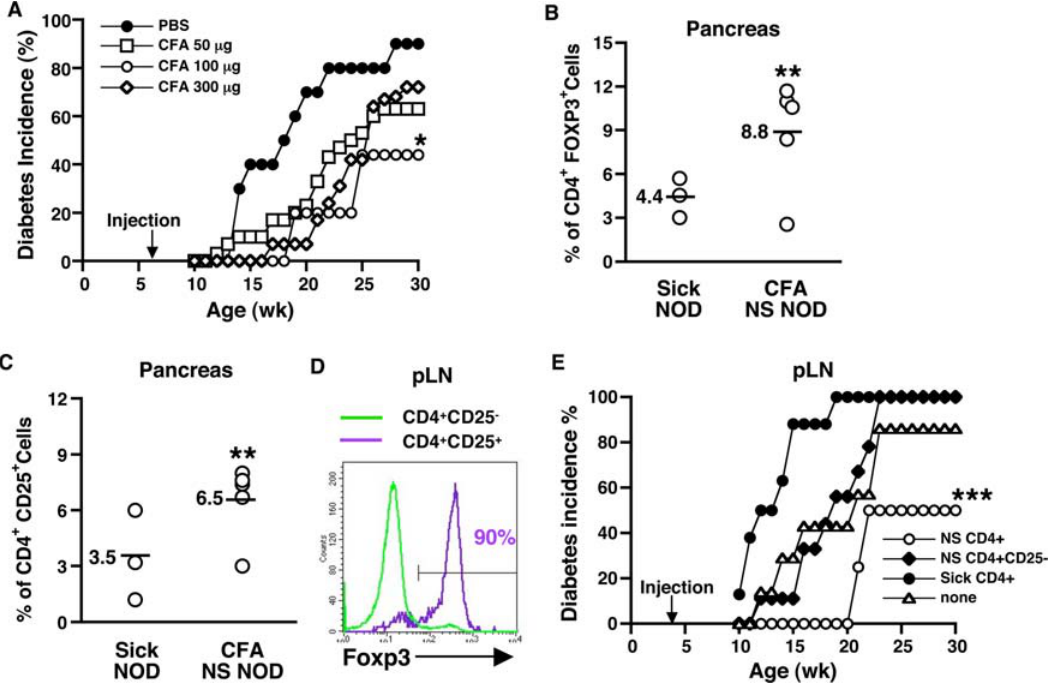
Figure 2. Disease-free CFA-treated NOD mice possess potent regulatory cells. Three different doses of CFA containing 50, 100 or 300 m g of Mycobacterium tuberculosis or PBS were administered s.c. to 6 week-old NOD mice. An * indicates a significant difference from the PBS control at p , 0.03 (A). Pancreata were harvested from 34 week-old Sick (Sick) or CFA-treated Non-Sick (NS) NOD mice and digested with collagenase. Cells from individual mice were labeled with anti-CD4, CD25 antibodies, and Foxp3 antibodies and analyzed by FACS H . Each point represents an individual animal. An ** indicates a significant difference from the Sick NOD group at p , 0.05 (B & C). Pancreatic LN cells were harvested from 30-week-old CFA- treated Non-Sick NOD mice, and labeled with anti-CD4, CD25 and Foxp3 antibodies, and analyzed by FACS H (D). Pancreatic LN cells from 30-week-old Sick or CFA-treated Non-Sick (NS) were pooled, CD4 + cells purified and 0.4 6 10 6 cells transferred into 4-wk-old NOD mice. Or purified CD4 + cells from pancreatic LN from 30-week-old CFA-treated Non-Sick (NS) were depleted of CD25 + cells (NS CD4 + CD25 2 ) and 0.4 6 10 6 of these CD4 + CD25 2 cells injected into 4-wk-old NOD mice. Blood glucose was monitored weekly and diabetes incidence determined. An *** indicates a significant difference from the untreated controls at p , 0.005